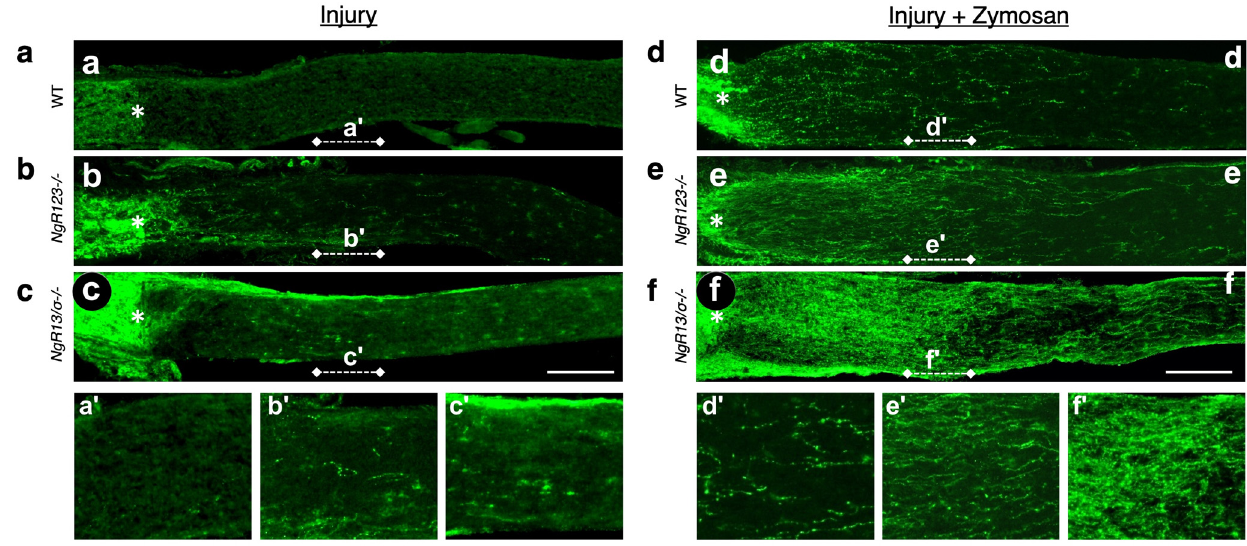
Figure 4. Synergy between intraocular inflammation and deleting receptors for cell-extrinsic suppressors of axon growth. ( a – f ) Longitudinal sections through the optic nerves of wild-type mice (WT) or mice lacking all 3 isoforms of the Nogo receptor (NgR123 − / − ) or of NgR1 and 3 plus PTPs, a receptor that mediates inhibitory effects of chondroitin sulfate proteoglycans (CSPGs). As indicated, mice either underwent optic nerve injury alone or with intraocular inflammation following intraocular injection of zymosan. ( a’ – f’ ) Regions of optic nerves shown at greater magnification in the corresponding panels below. Note the dramatic increase in regeneration when combining intraocular inflammation with deletion of receptors for the inhibitory molecules associated with myelin and CSPGs. Asterisks show lesion site [40].